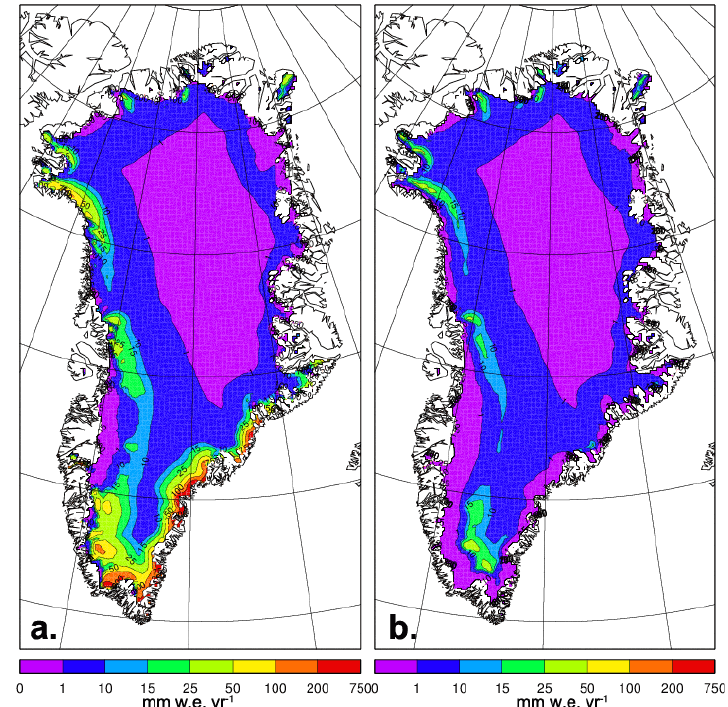
Fig. 8. Difference in refreezing when including rain in W r (Yes–No) for JH2000 (a) and HdW1999 (b) , using RACMO2 input fields.